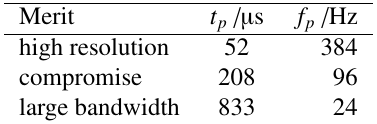
Table 2. Proton pulse sequences for three target stations at HBS adjusted according to 2 % duty